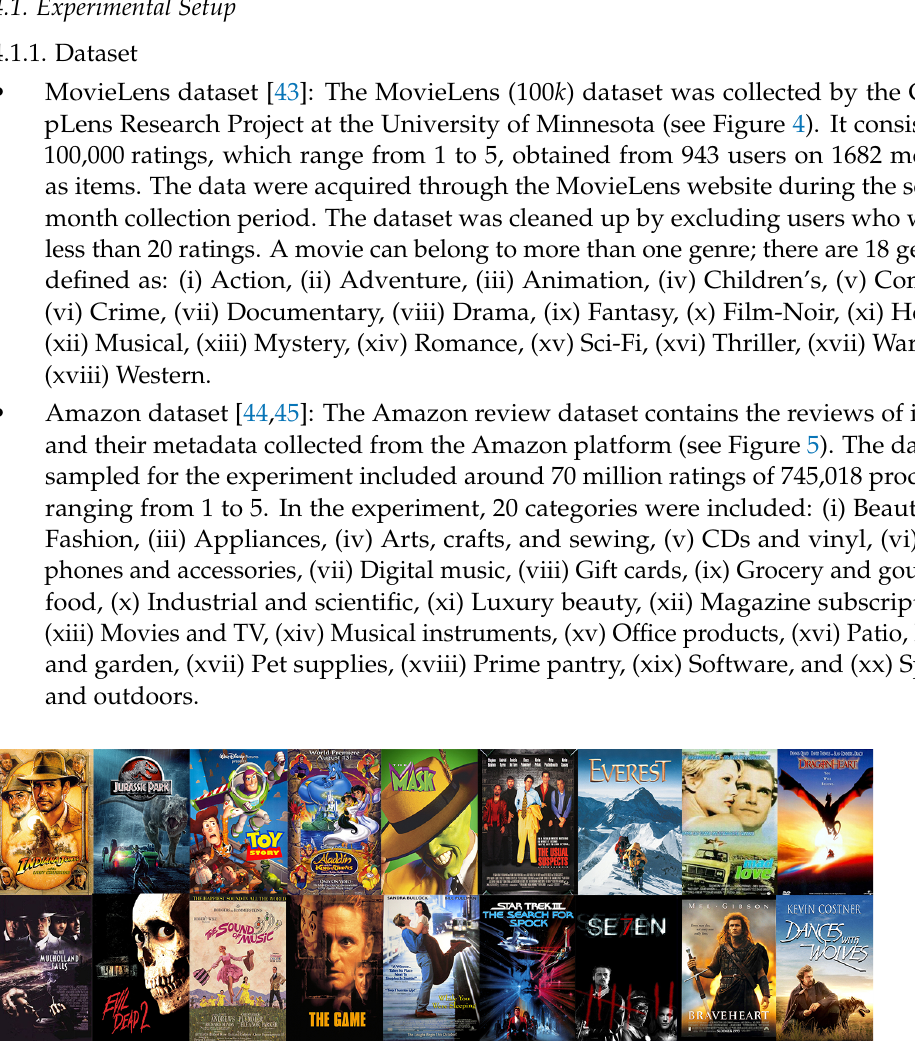
Figure 4. Examples of movies from different genres (MovieLens dataset).